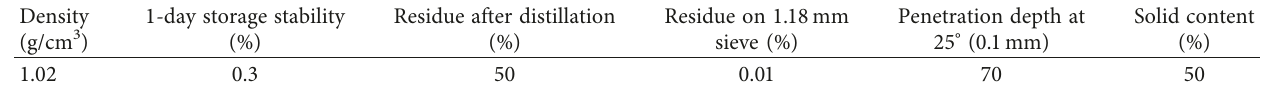
Table 2: Properties of anionic asphalt emulsion.